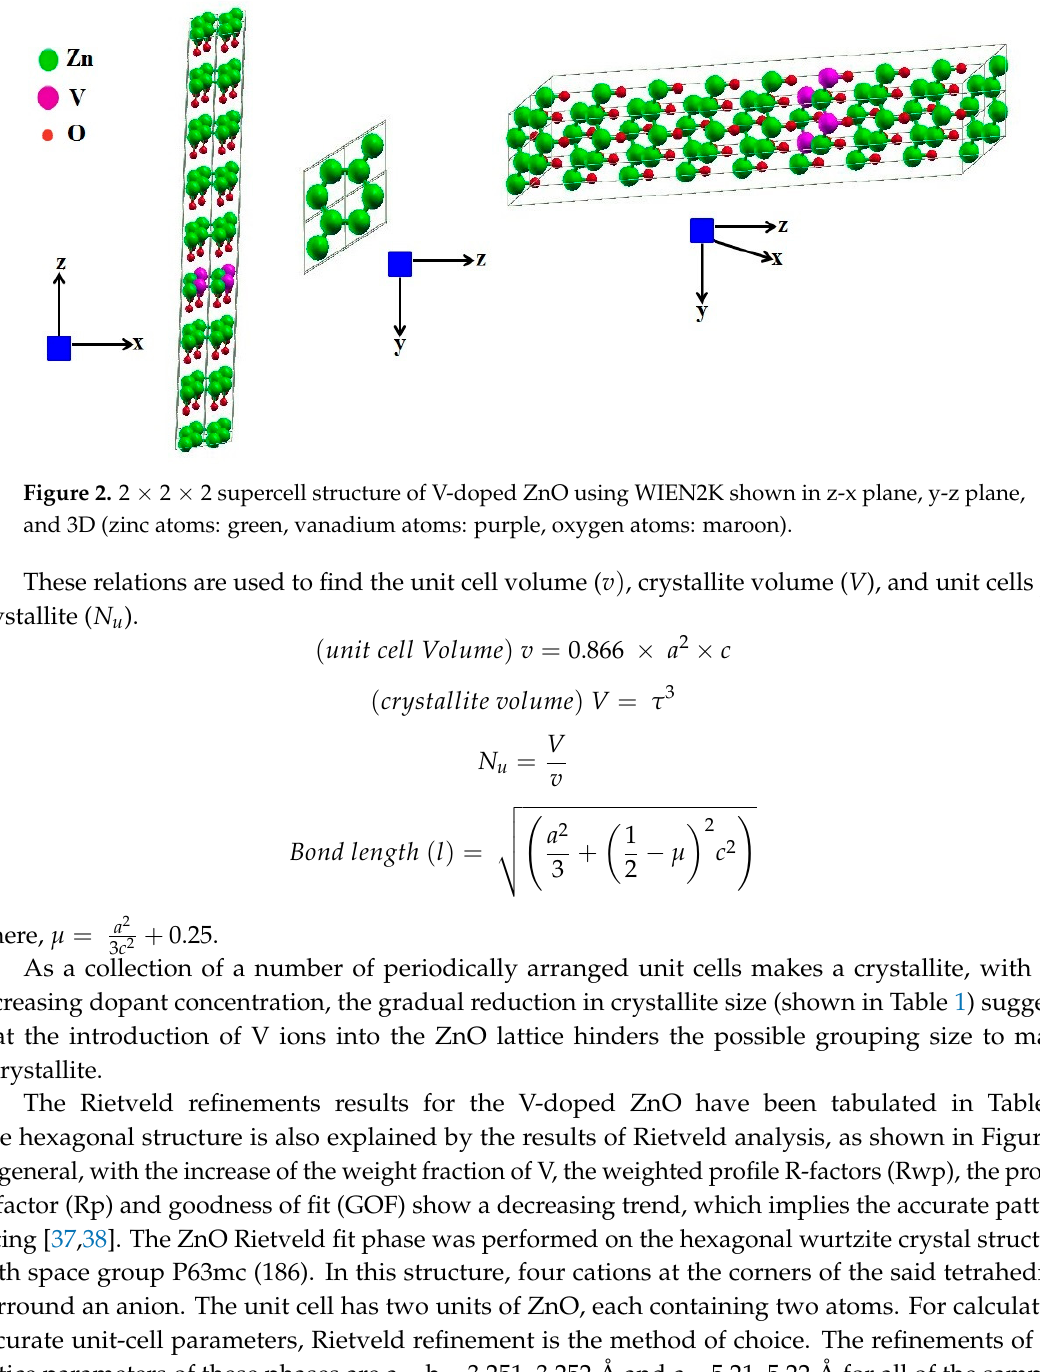
Table 2. Refined structure parameters for pure and 2–10% vanadium-doped ZnO nanocrystalline. Sample c (Å) Residual Factors Values